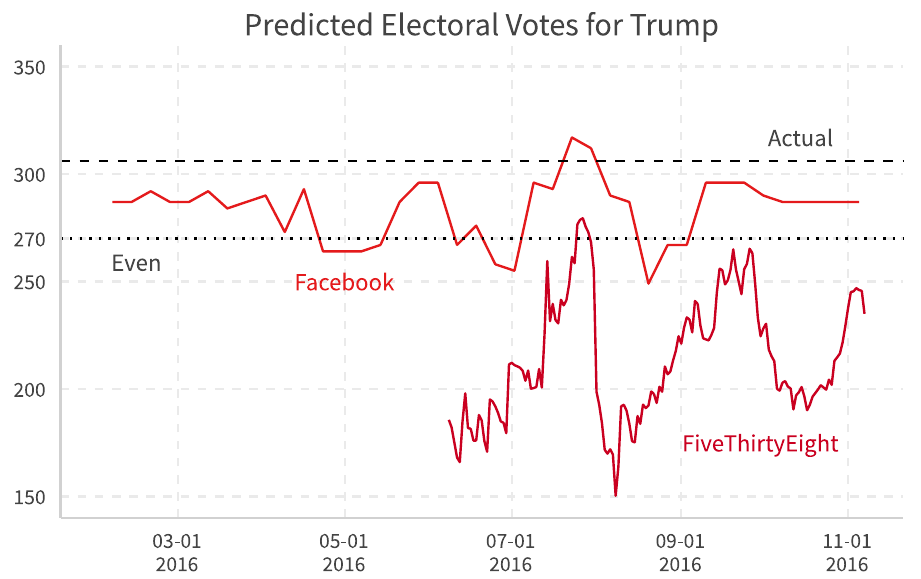
Fig 14. Expected electoral votes based on Facebook and polling. Facebook: Trump wins a state if the share of user’s ideology closer to Trump is higher. 538: “Nowcast” from [27].